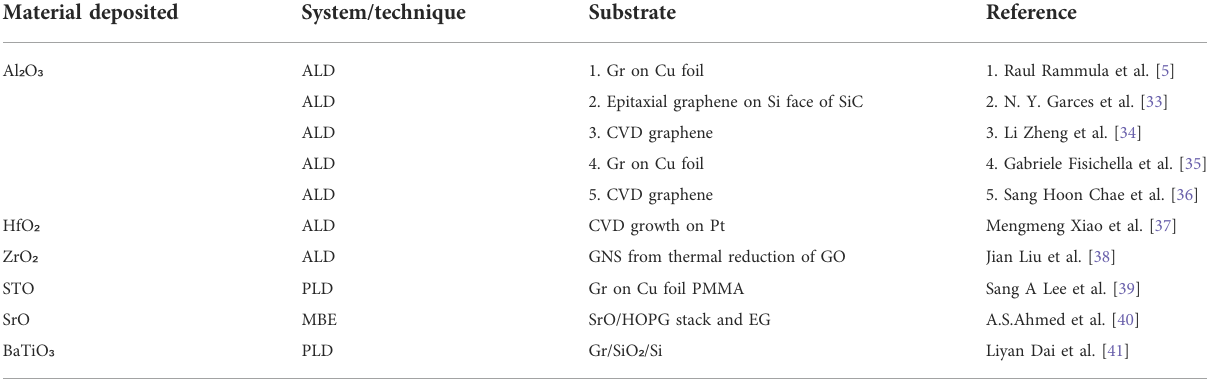
TABLE 2 High- κ dielectric on